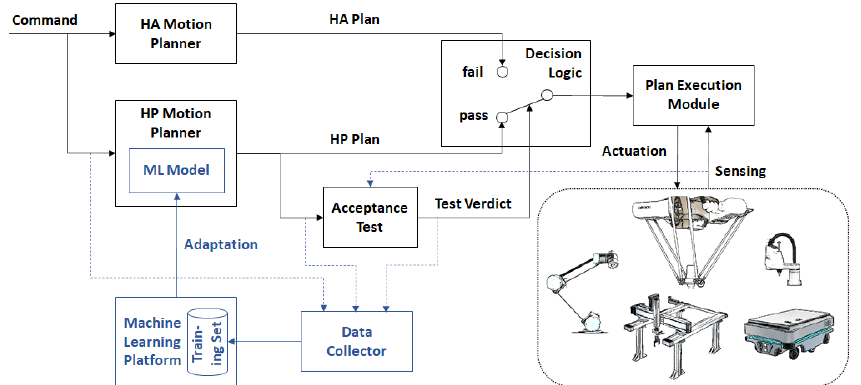
Figure 2. The proposed adaptive simplex architecture (ASA). The elements in blue illustrate the extensions to the original simplex architecture (SA). HA: high-assurance, HP: high-performance, and ML: machine learning.